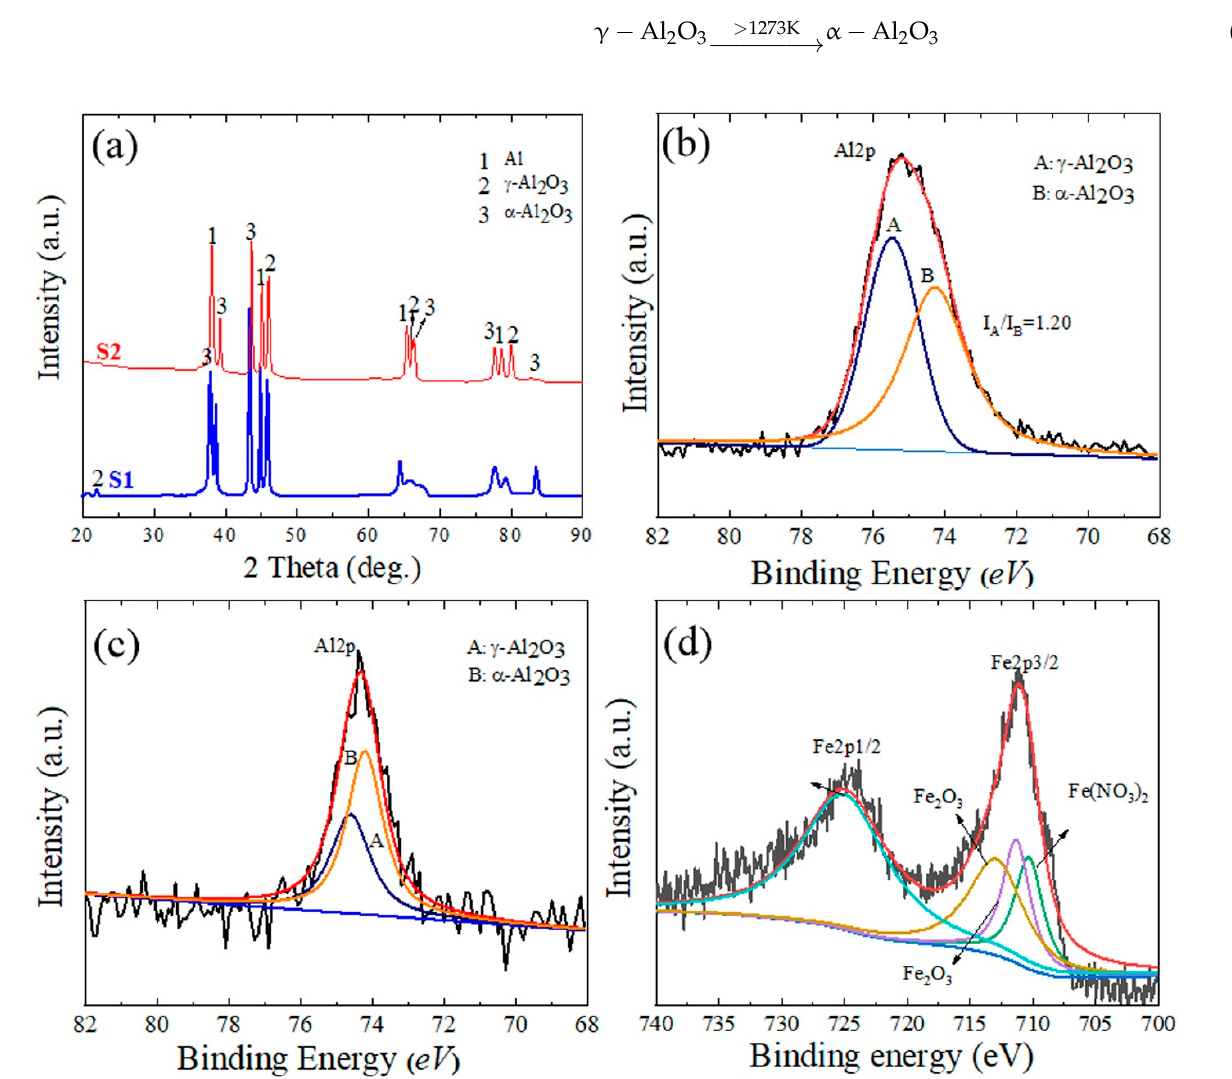
Figure 4. ( a ) XRD patterns of the S1 and S2 samples. ( b ) XPS data of the Al2p spectrum for the S1 sample. ( c , d ) XPS spectra of Al2p and Fe2p for the S2 sample, respectively.